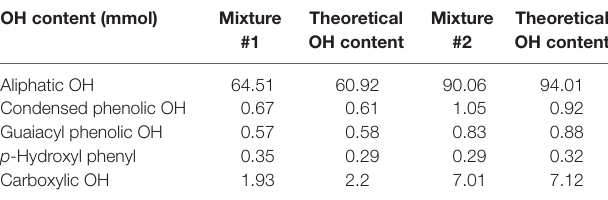
TaBle 2 | Hydroxyl group contents of two mixtures of cellulose, hemicellulose, and lignin. Oh content (mmol)